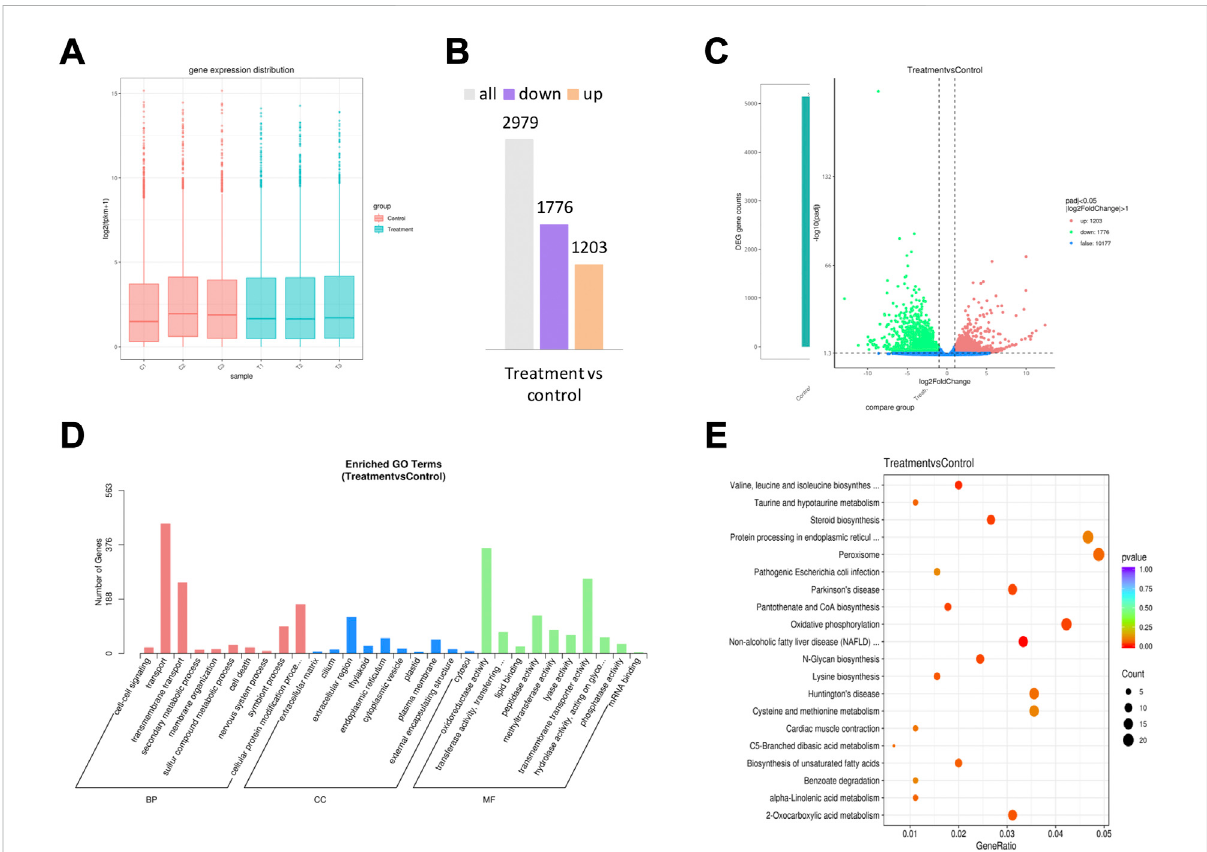
FIGURE 6 RNAsequencinganalysis. F.solani speciescomplexcellsundertreatmentwith5.76 μ g/mlof1,8-cineoleat27 Cfor72 h. (A) Theboxplotshows thevariation in mRNA expression. (B) Statisticalchartof DEGs. (C) Volcano plots of DEGs for F. solani species complex bio fi lm formedinresponse to 5.76 μ g/ml1,8-cineole;thereddotsrepresenttheup-regulatedgenes,thegreendotsrepresentthedown-regulatedgenes,andthebluedottedline represents the threshold line of differential gene screening criteria. (D) GO analysis and (E) KEGG pathway classi fi cation analysis of upregulated and downregulated genes.